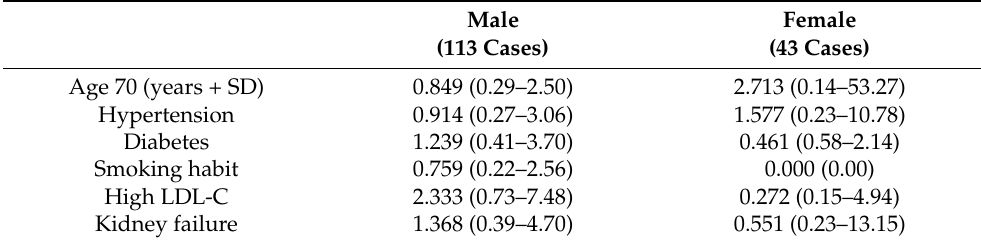
Table 3. Impact of high hs-CRP in male and female